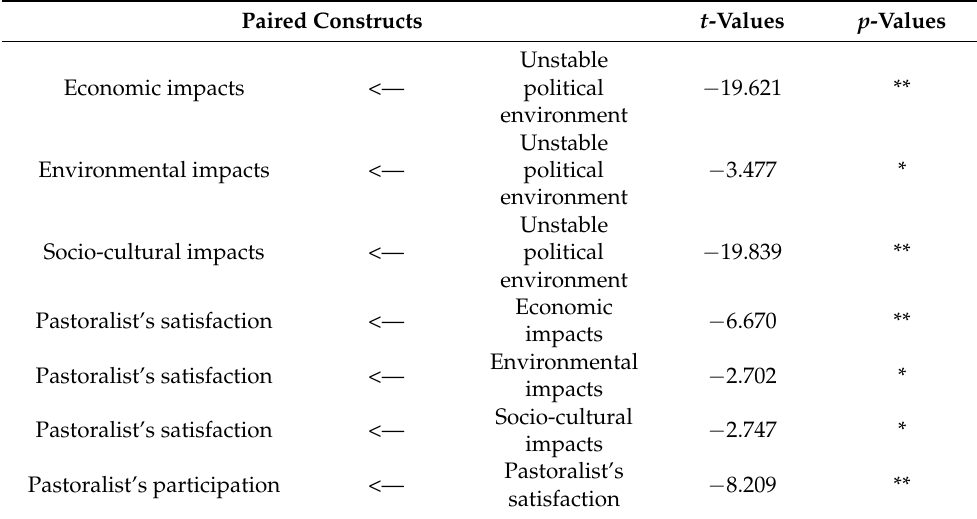
Table 3. The path coefficients between paired constructs (associated with impacts and perceptions of political instability) in Borana rangeland. Paired Constructs t -Values p -Values Economic impacts